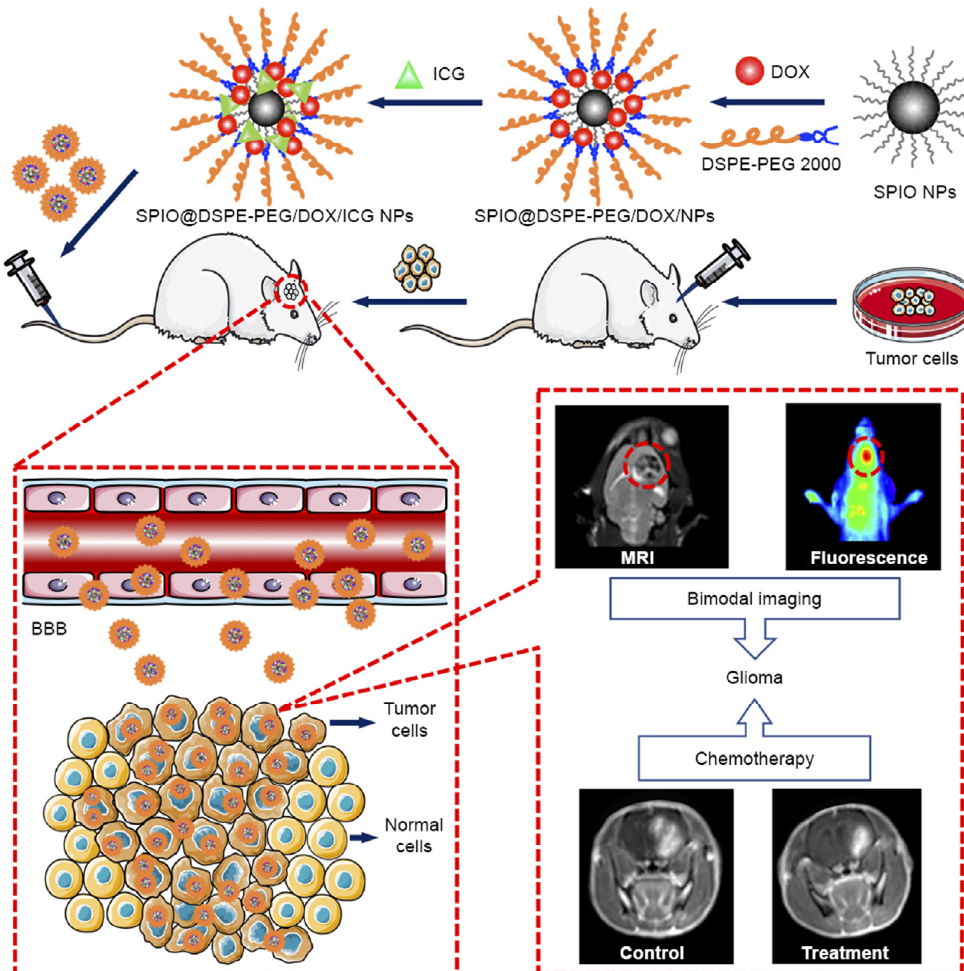
Figure 4. Illustration of the preparation and utilization of SPIO@DSPE-PEG/DOX/ICG NPs in MR/NIR fluorescence dual-modal imaging and chemotherapy of glioma through intravenous injec- tion. Reproduced with permission from reference [17]. Copyright 2019 Dove Medical Press Limited.